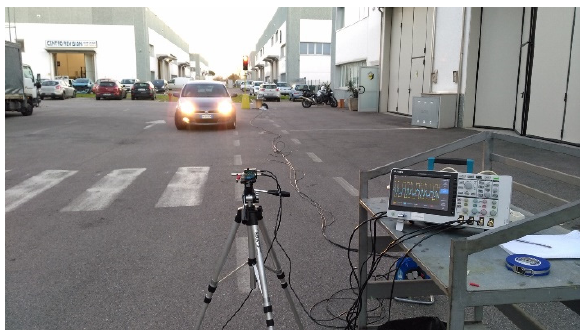
Figure 3. I2V measurements campaign using a VLC-based traffic-light (city of Prato).